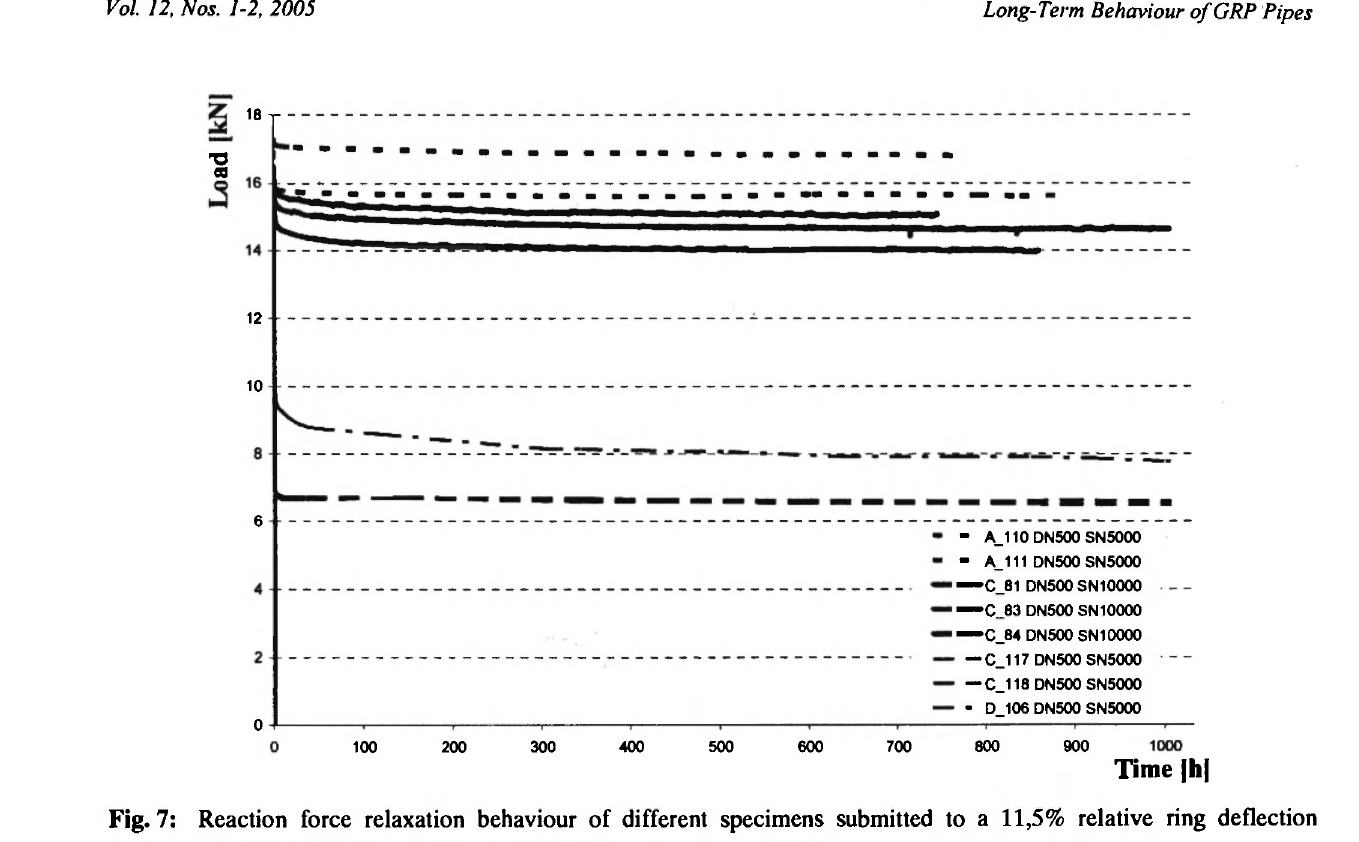
Fig. 7: Reaction force relaxation behaviour of different specimens submitted to a 11,5% relative ring deflection condition after pre-conditioning of 1000h under water at 50°C